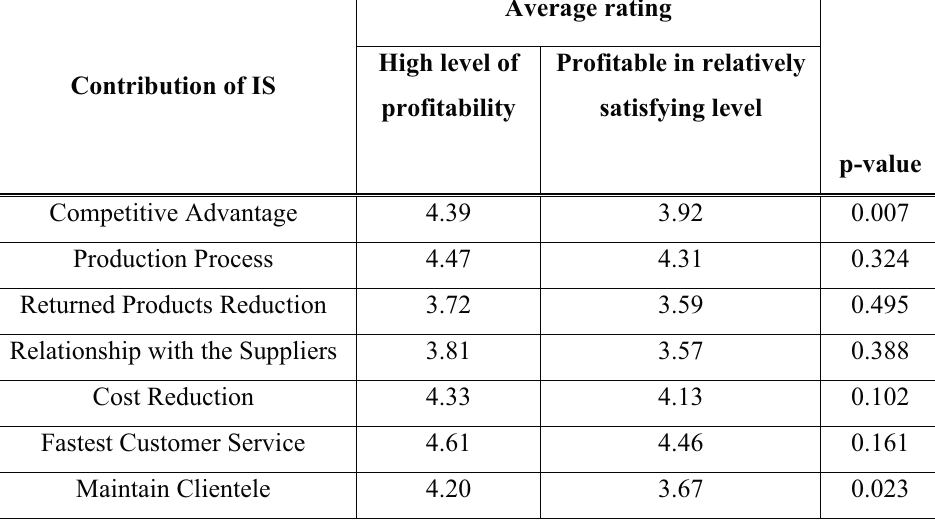
Figure 6. Contribution of IS adoption—level of